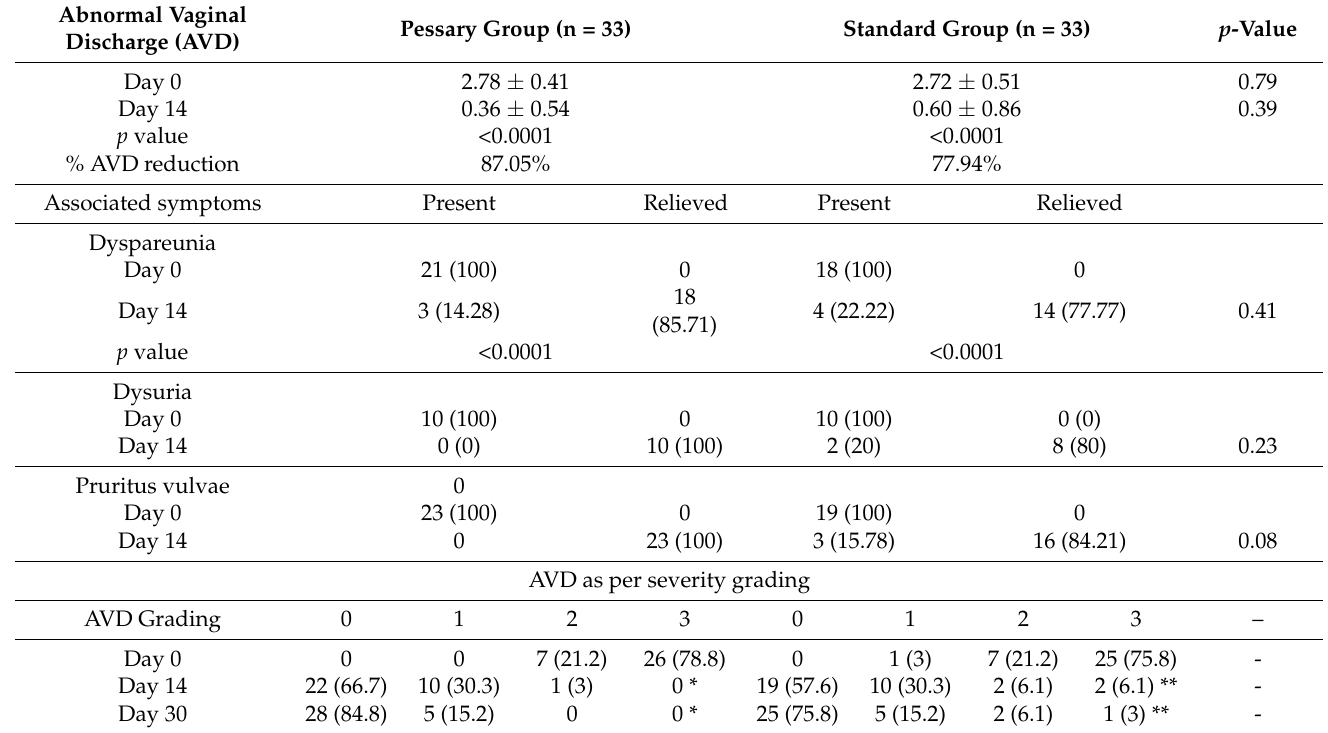
Table 5. The primary outcome measures are based on abnormal vaginal discharge and associated symptoms of